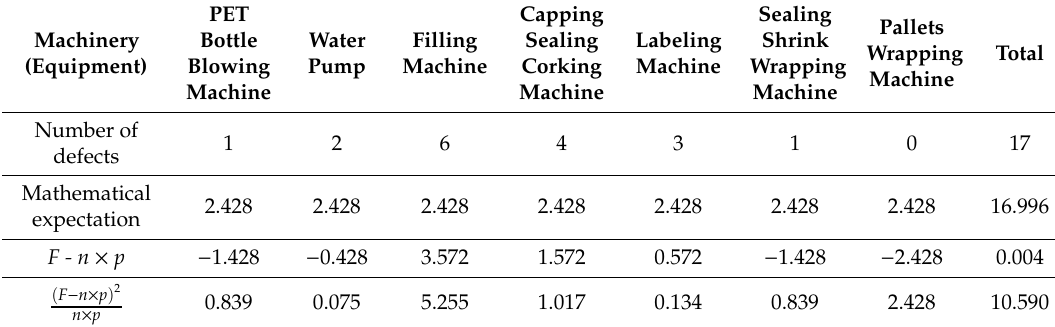
Table 6. The results of the χ 2 test calculation for equipment occurrences of defects.